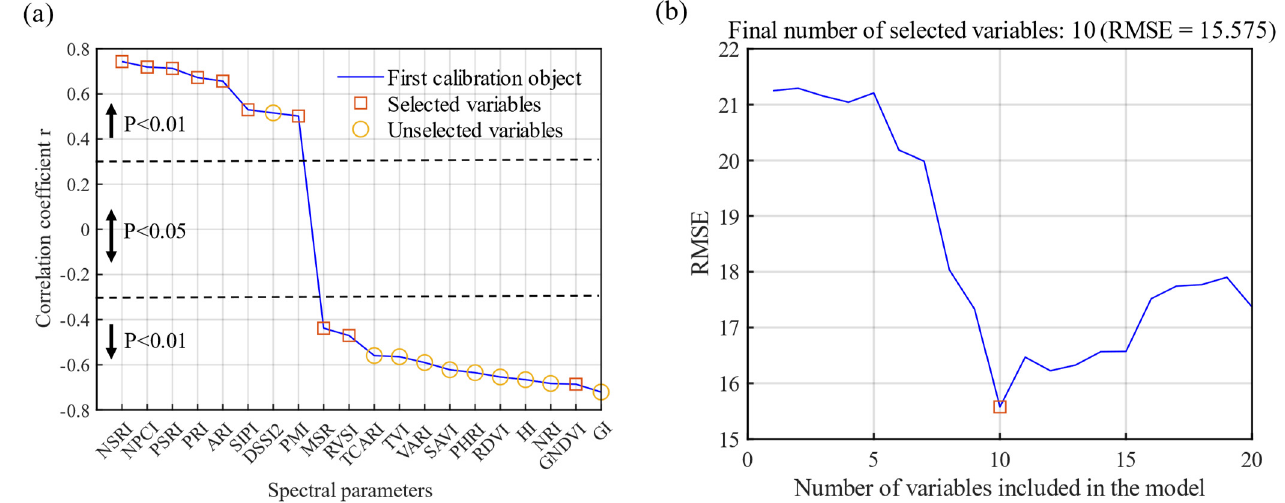
Figure 5. Root mean square error ( a ) in the optimal variables selected using successive projections algorithm (SPA) and correlation ( b ) between vegetation index (VI) and disease index (DI).